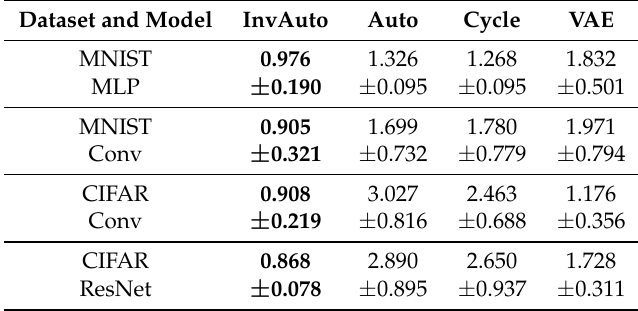
Table 2. Mean and standard deviation of the (cid:96) 2 -norm of the rows of E . InvAuto achieves the (cid:96) 2 -norm of the rows that is the closest to the unit norm. Best performer is in